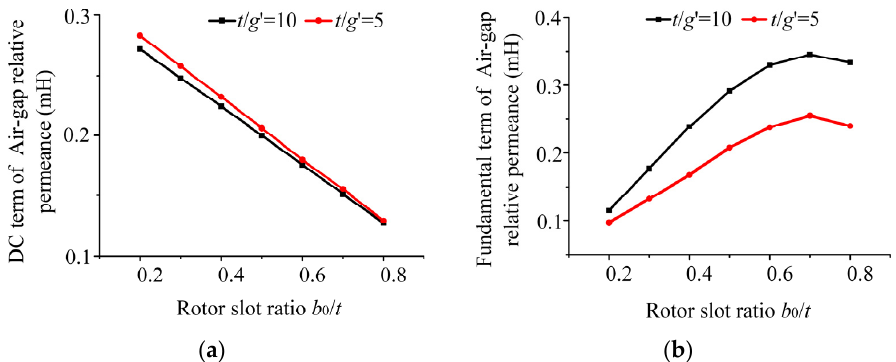
Figure 12. Variation in air-gap relative permeance with rotor slot ratio: ( a ) DC term of Air-gap relative permeance versus Rotor slot ratio; ( b ) Fundamental term of Air-gap relative permeance versus Rotor slot ratio.